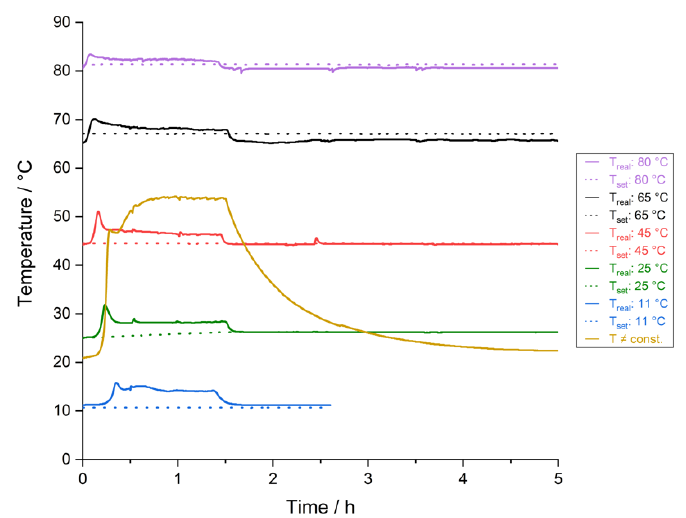
Figure 3. Detailed temperature curve for leaching at T: 65 °C; solid conc.: 50 g/0.1 L. In Figure 4 the corresponding curves for leaching experiments at different constant temperatures are compared. The chosen temperatures were 11 °C, 25 °C, 45 °C, 65 °C and 80 °C. One curve shows the temperature for leaching without temperature maintenance by a thermostat.